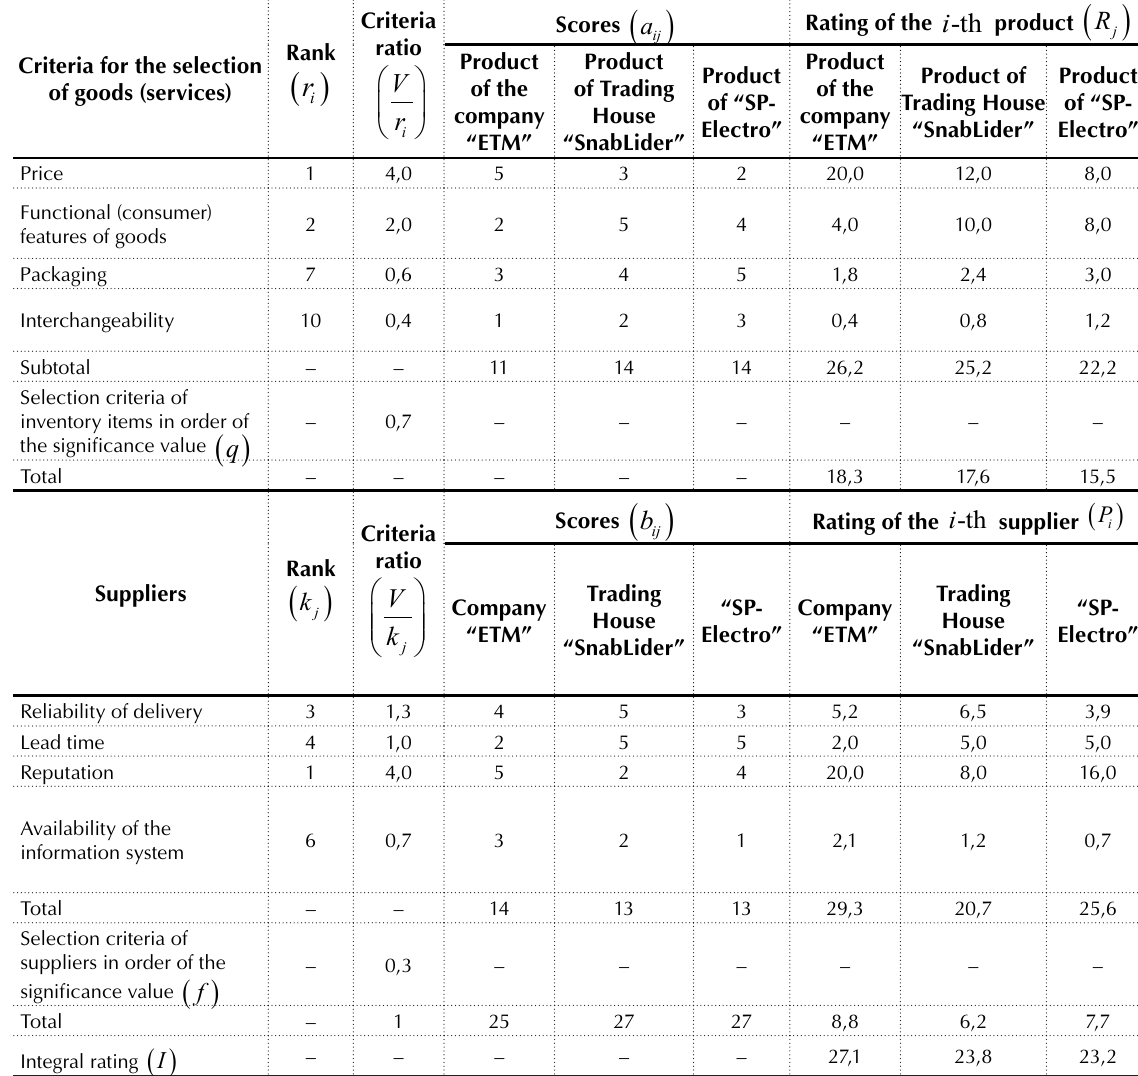
Table 10. Methodology for evaluating inventory items and suppliers by calculating